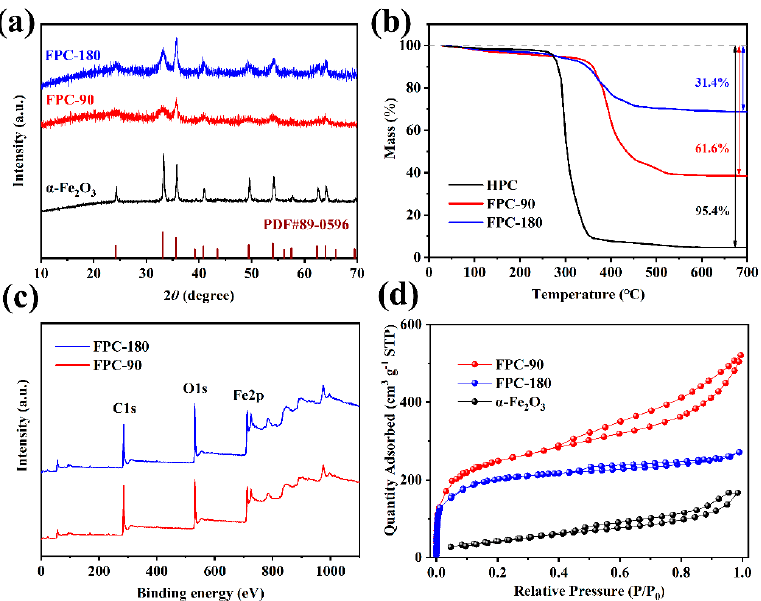
Figure 3. The XRD patterns ( a ), TGA analyses ( b ), XPS spectra ( c ), and N 2 adsorption − desorption isotherms ( d ) of FPC samples.